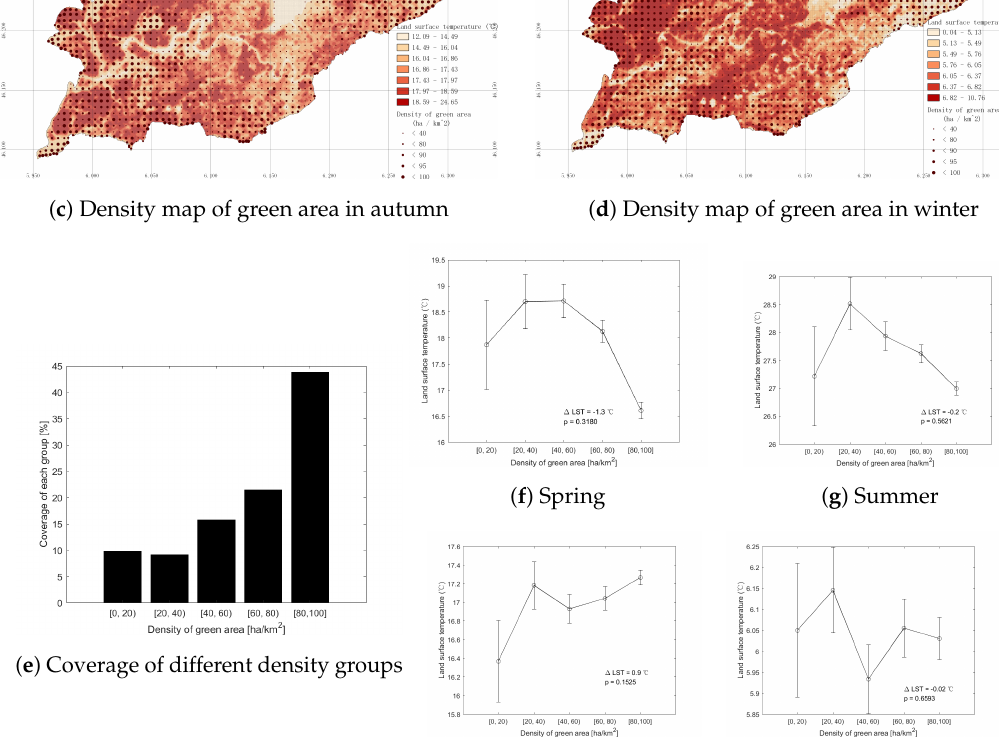
Figure 14. Density map of green area for four seasons in Geneva. Different colored areas and sized circles indicate various temperatures ( ◦ C) and different density groups respectively. Figures ( f – i ) present the relationships between LST and density of green area with 95% confidence